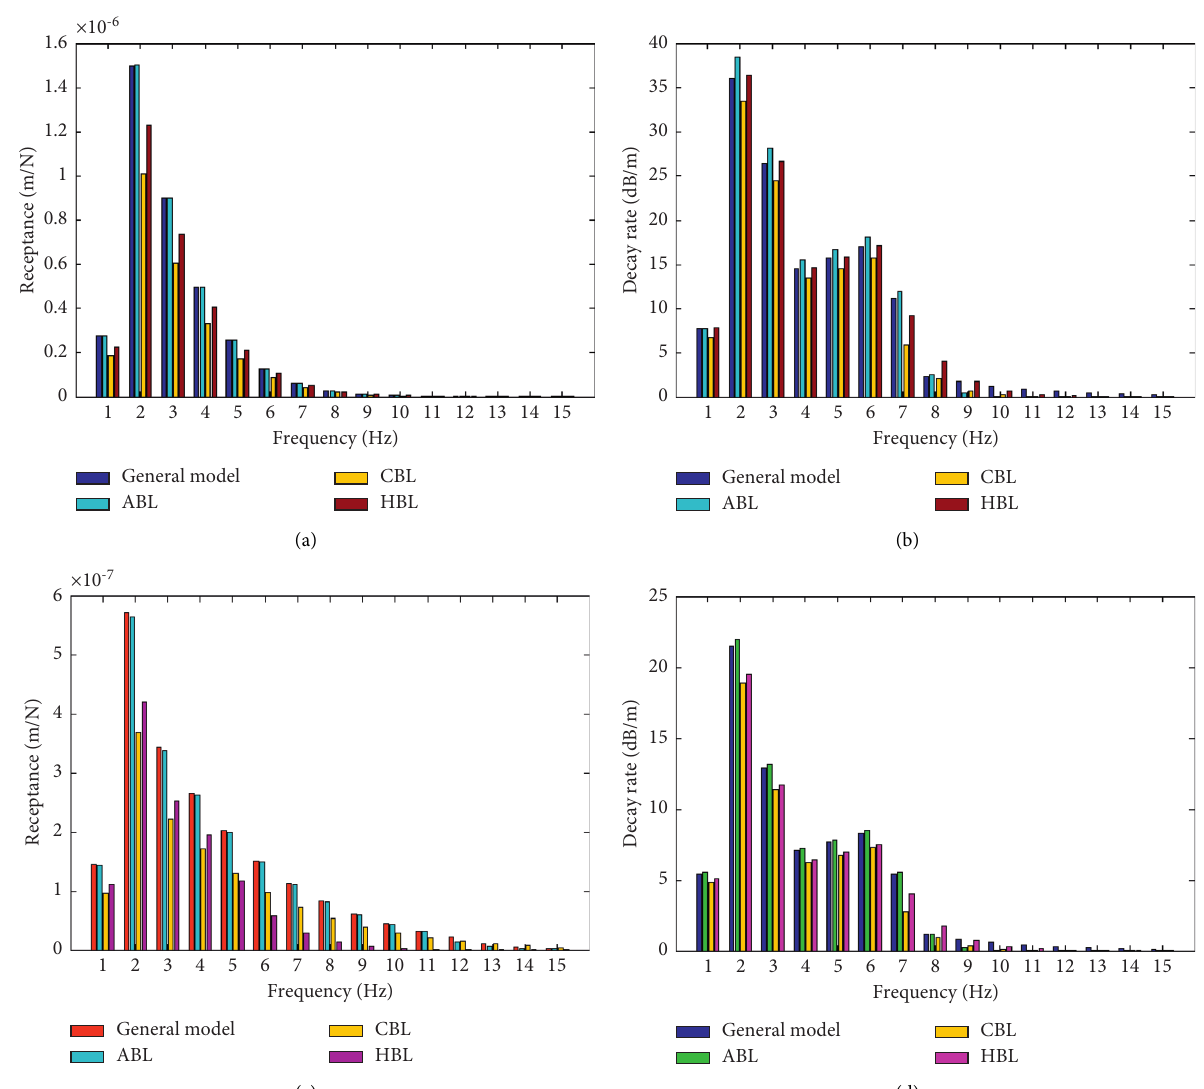
Figure 11: The effect of modulus and thickness on receptance and decay rate in layers under load amplitude of 25 tons: (a) modulus change behavior of the slab track layers under receptance, (b) modulus change behavior of the slab track layers under decay rate, (c) thickness change of the slab track layers under receptance, and (d) thickness change of the slab track layers under decay